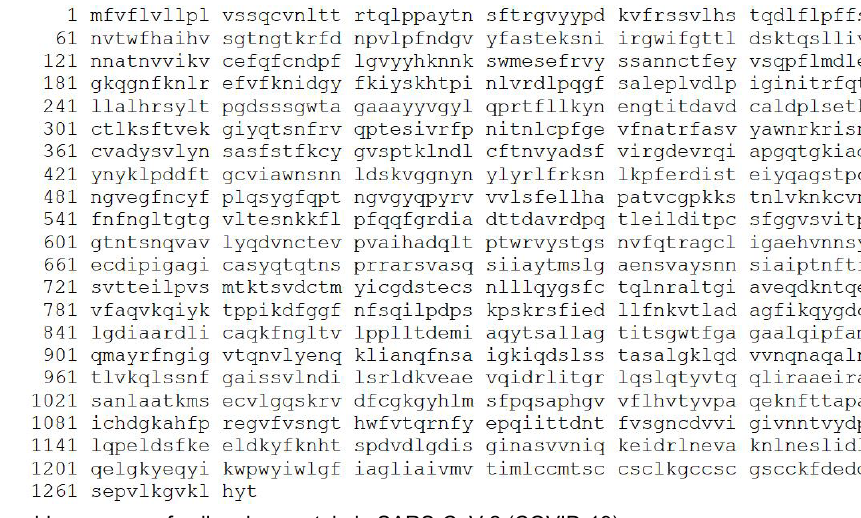
Figure 1. Amino acid sequence of spike glycoprotein in SARS-CoV-2 (COVID-19)